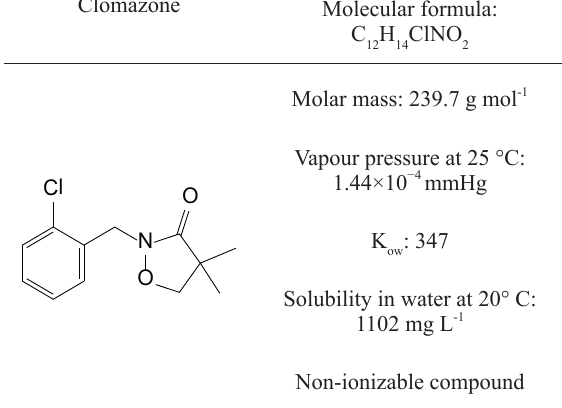
Physicochemical properties of Clomazone (CMZ). Physicochemical Clomazone